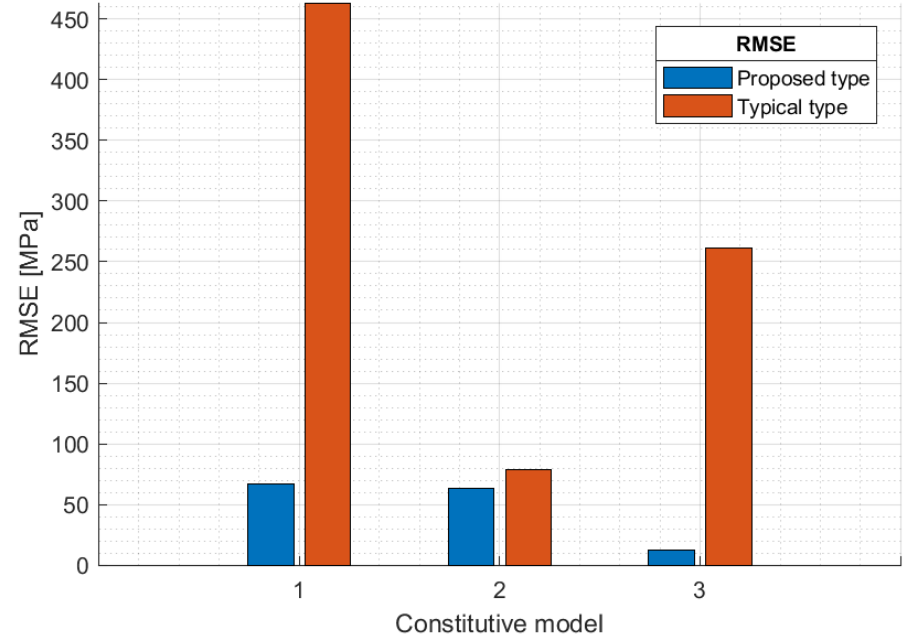
Figure 6. Quantitative comparison between the typical and proposed methods.